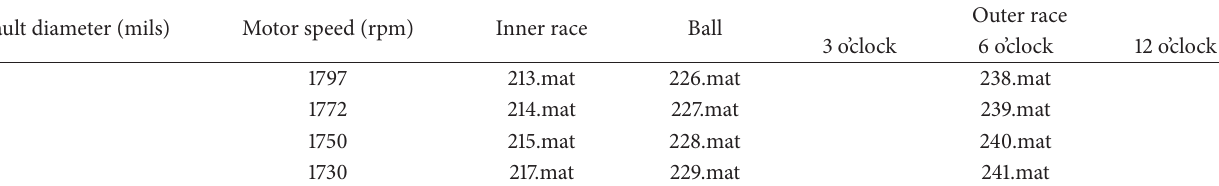
Figure 7: A flowchart of the proposed method. Table 1: Data